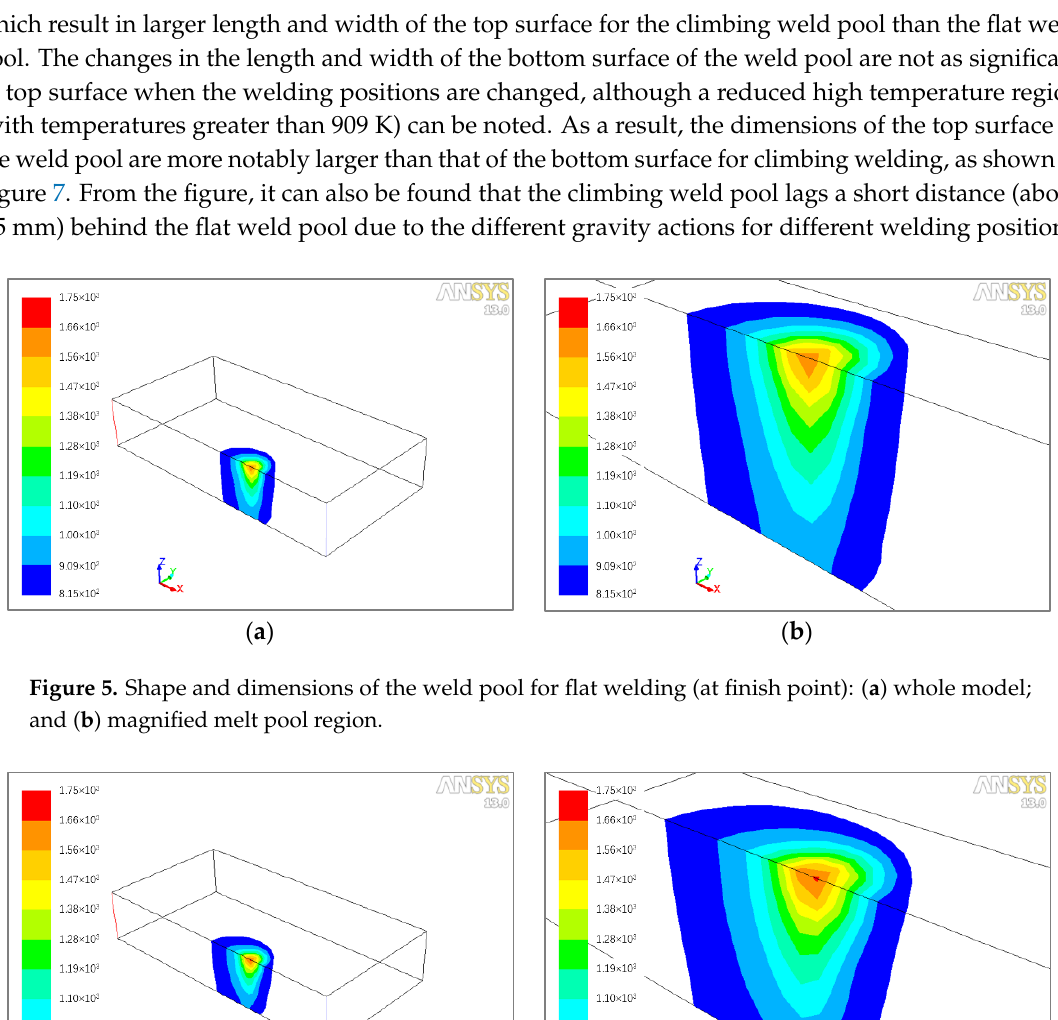
Figure 6. Shape and dimensions of the weld pool for climbing welding (at start point): ( a ) whole model; and ( b ) magnified melt pool region.